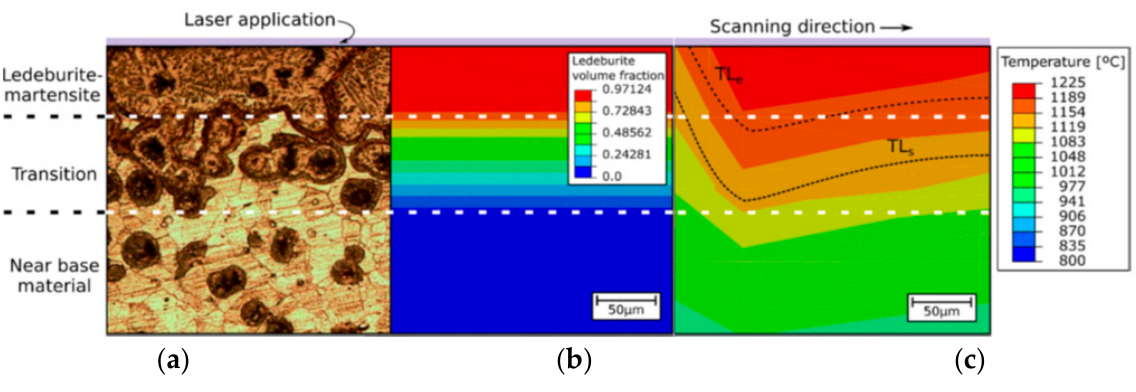
Figure 19. ( a ) Optical microscopy image of resulting microstructure of modified DI. ( b ) Computed ledeburite volume fraction at fixed laser parameters. ( c ) Computed temperature distribution at a fixed instant and parameters as a function of depth (Reprinted with permission from ref. [71]. 2021 Springer Nature B.V.).